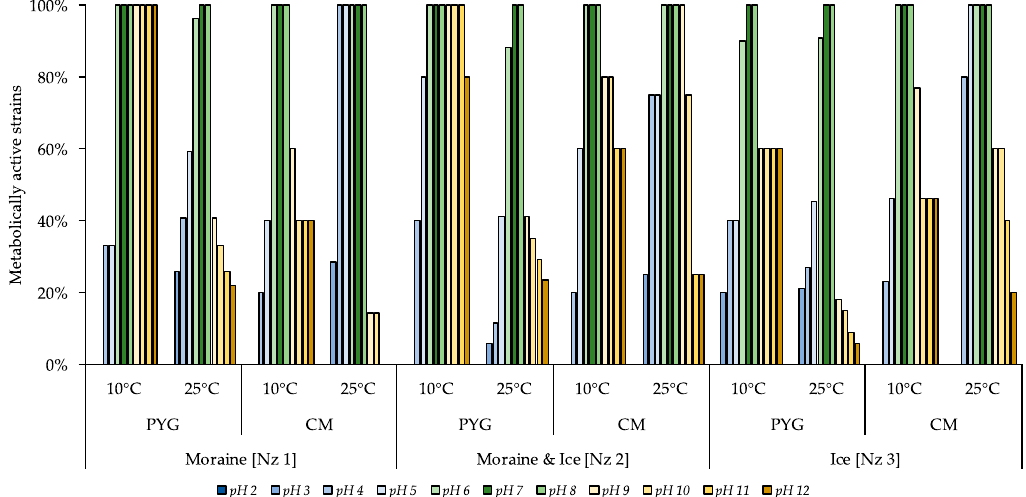
Figure 7. Isolated strains’ resistance to pH of the media. Vertical axis: proportion of the strains in the culturable community able to reproduce in considered conditions. Horizontal axis: the tested communities. Temperature and medium abbreviations indicate the isolation conditions. PYG and CM—peptone yeast glucose and modified Czapek media, respectively.